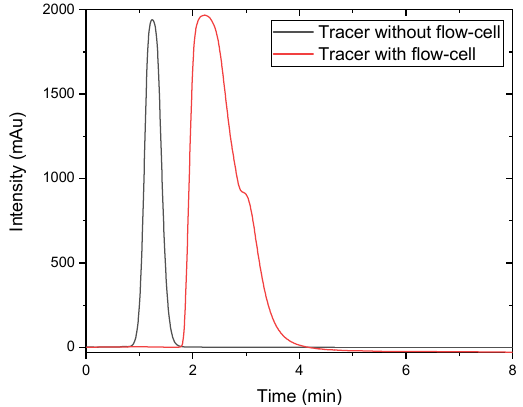
Figure 8. Tracer chromatogram with and without Raman flow-cell. In ATPE, raw FTIR data of light phase after ATPE reveal less obvious deviations when compared to Raman raw data. It is, however, important to note that the differences that are clearly visible in raw Raman data are only caused by the strong baseline increase due to underlying fluorescence. Indeed, the deviations in-between the FTIR spectra are less pronounced compared to Raman spectra. PLSR coefficients for mAb, HMW, and LMW are generally lower compared to the other methods. A possible explanation for this is that while amide I band can be identified in the FTIR spectra, amide II, and amide III bands are far less pronounced. Hence, the spectral information provides less distinguishable contributions by mAb, and all other species in the multicomponent mixture. Since PLSR-model building relies on these different contributions to the fingerprint of the multicomponent matrix, regression becomes less efficient. The regression coefficients in ATPE were 0.94, 0.94, 0.98, with RMSEs of 0.167, 0.013, and 0.5 g/L, which is 9, 8, and 3.5% of the final mAb, HMW, and LMW concentrations,